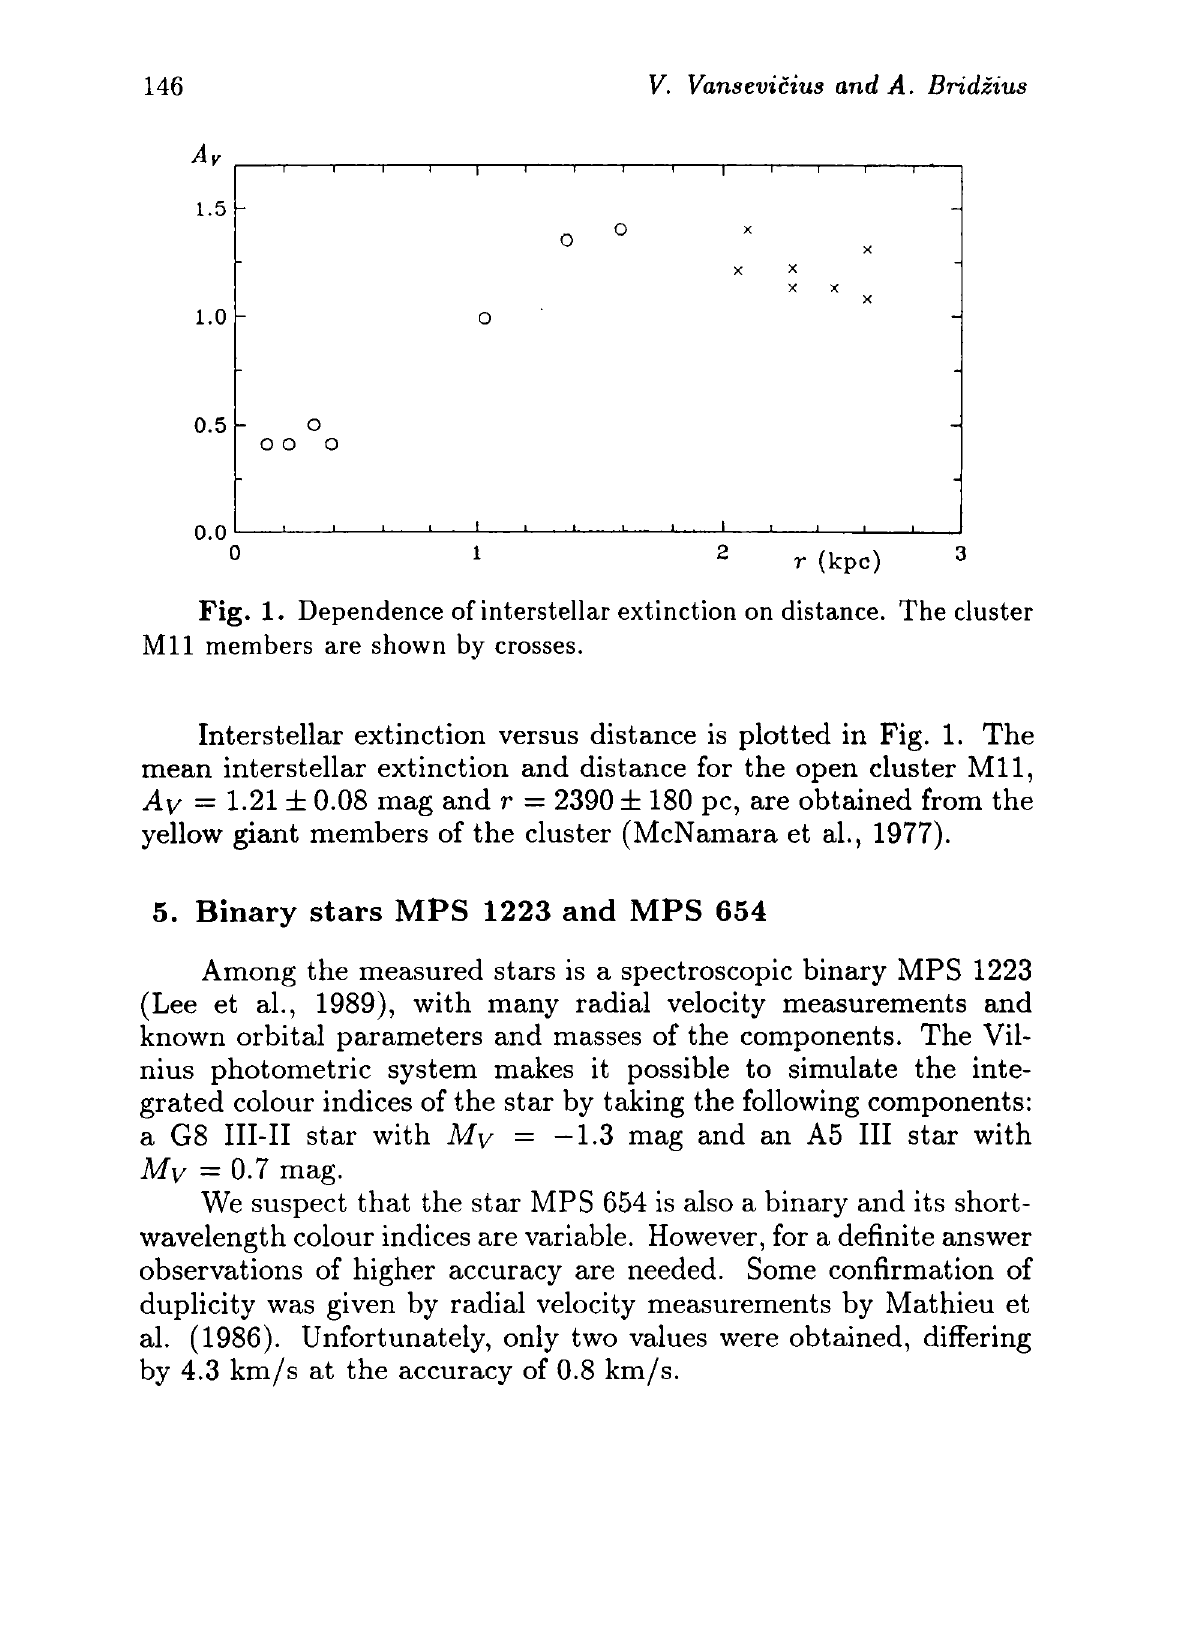
Fig. 1. Dependence of interstellar extinction on distance. The cluster M il members are shown by